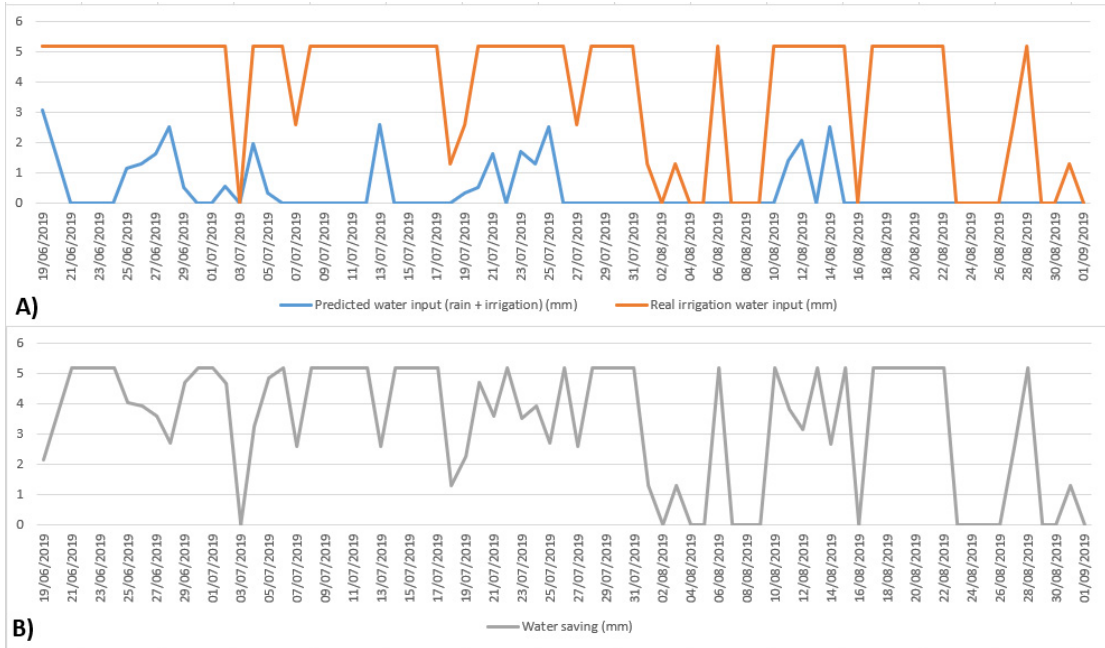
Figure 9. ( A ) Daily irrigation comparison between the partial least squares (PLS) model predicted (proposed) and the real irrigation input water (mm); ( B ) the water-saving comparison (mm).